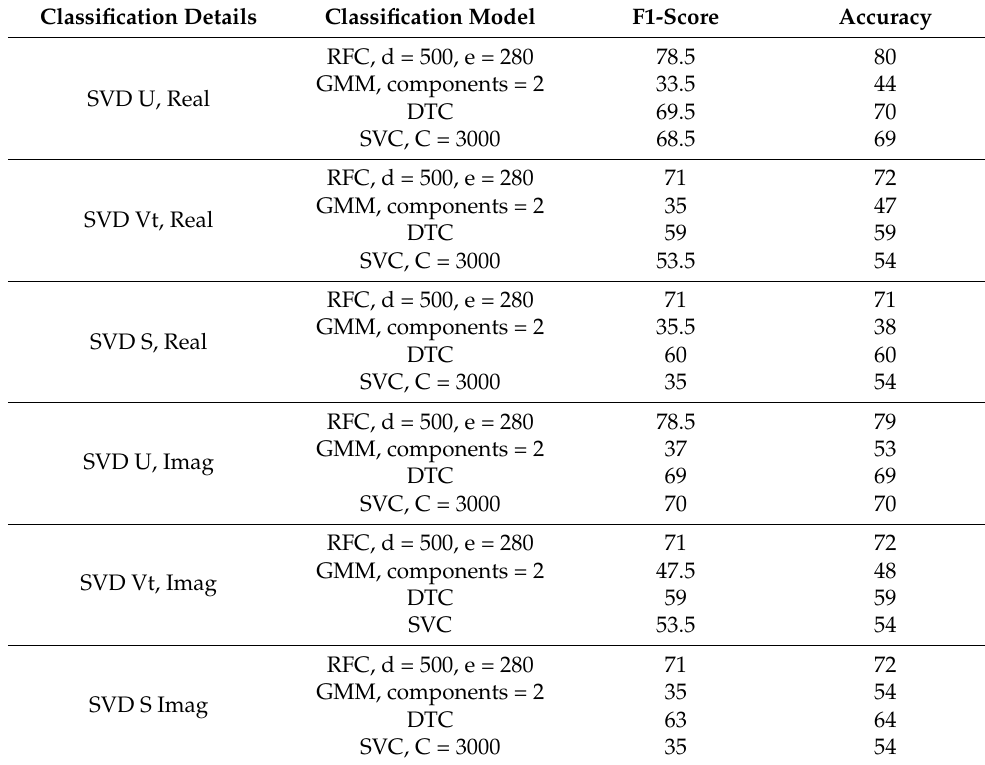
Table 3. Healthy vs COPD classification baseline results. All the baseline results have been achieved with the following parameter settings: Random forest (RFC): d = 500, e = 280 (in these, d stands for depth, and e stands for the number of estimators); GMM: components = 2, covariance = full; SVC: gamma = auto, C =